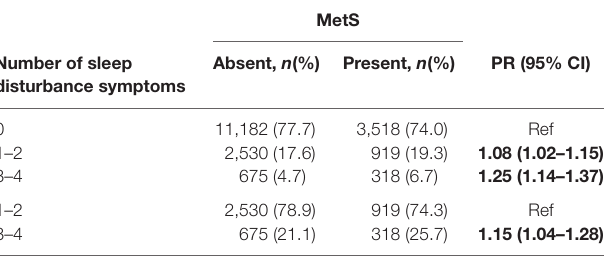
TaBle 3 | Association between the number of self-reported sleep disturbance symptoms and prevalence of MetS.